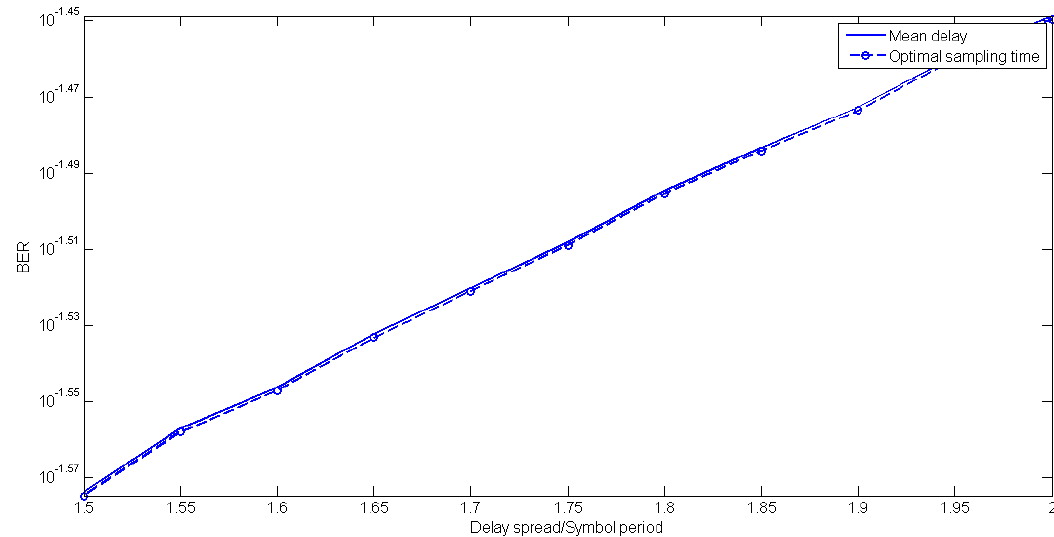
Figure 8. BER floor vs. rms delay spread for 16 QAM modulation for optimal and mean-delay sampling.